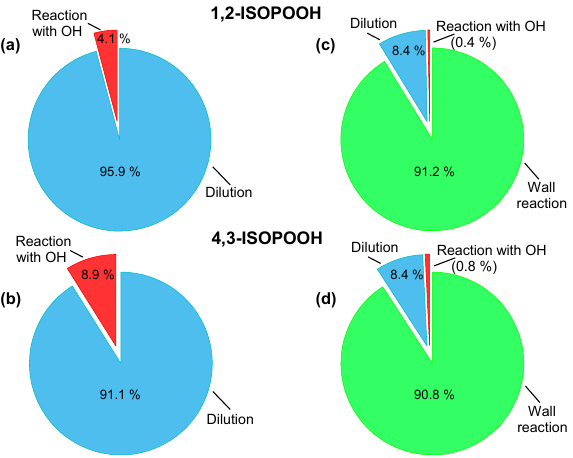
Figure 6. Influence of conversion efficiency on the agreement of modeled VOC and measured VOC concentrations ranging from a conversion efficiency of 0% (no wall reaction) to an efficiency of 100% (complete decomposition upon wall collision). The shaded red area corresponds to the uncertainty in the measurements of